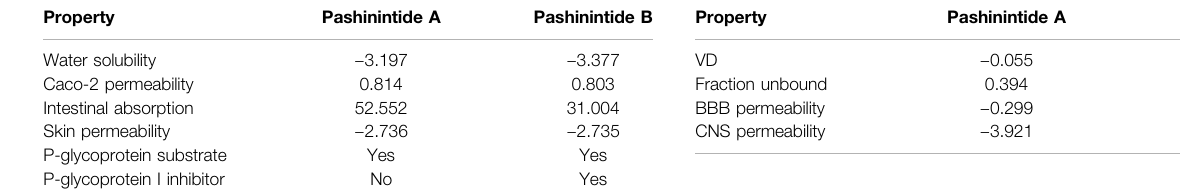
TABLE 4 | Absorption properties of the Pashinintides A and B. Property